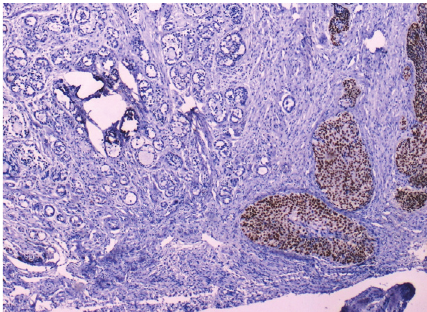
Figure 4: Immunostaining with P63: squamous cell component is positive (right), while adenoid cystic component is negative